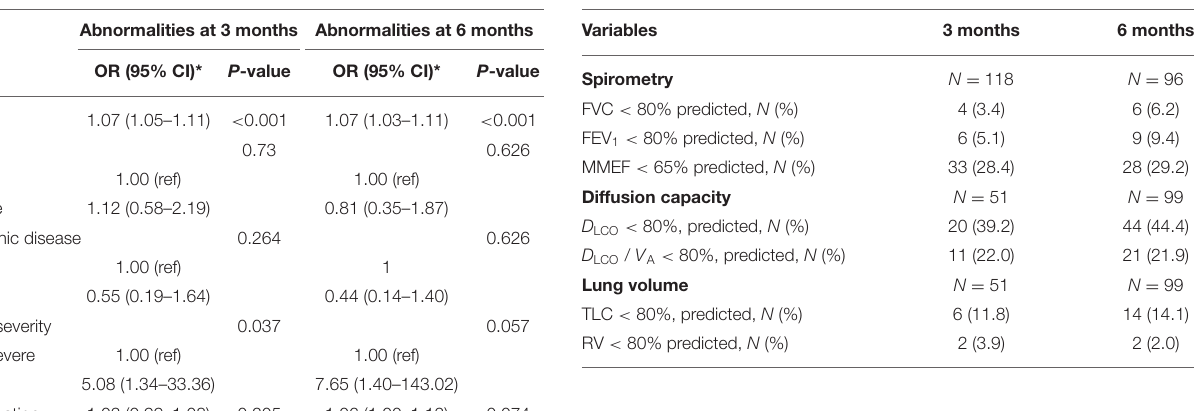
TABLE 3 | Multivariable analysis of risk factors for CT abnormalities. TABLE 4 | Pulmonary function of COVID-19 patients at